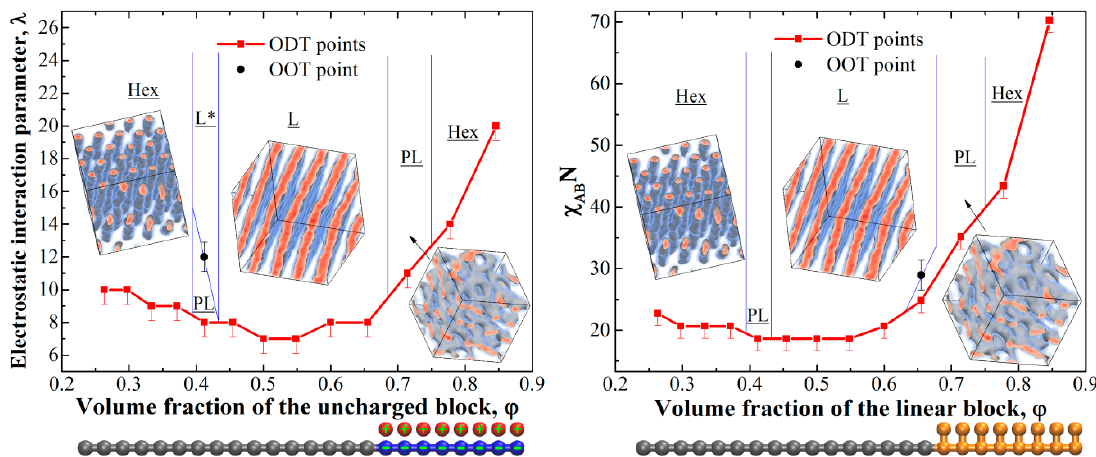
Figure 1. Phase diagrams for melts of diblock-copolymers with one charged block ( left ) and corresponding uncharged diblock-copolymers for the main (linear) chain length of N = 24 ( right ); L—lamellae, L*—defective lamellae, PL—hexagonally perforated lamellae, Hex—hexagonally packed cylinders. The lines show the expected positions of the boundaries between the phases and are given as a guide for the eye. The studied chain architectures at ϕ = 0.5 are shown below each diagram.